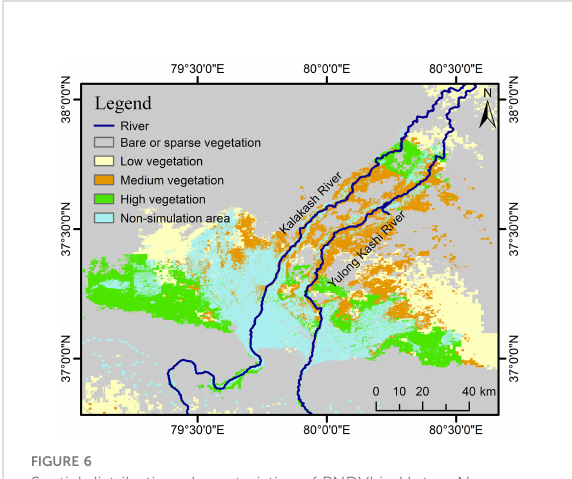
FIGURE 6 Spatial distribution characteristics of PNDVI in Hotan. Non- simulation area refers to irrigated cropland, impervious surface, and water body.